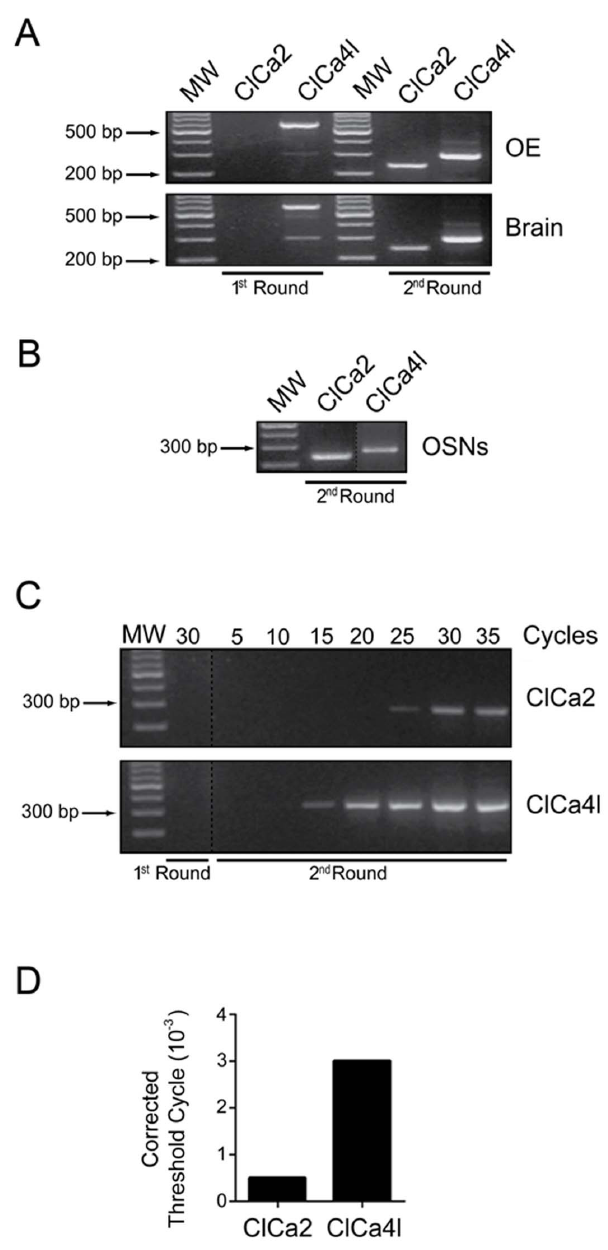
Figure 2. ClCa2 and ClCa4l are expressed in rat olfactory epithelium and olfactory sensory neuron. A. ClCa2 and ClCa4l mRNA expression in rat olfactory epithelium after the first (1 st ) and second (2 nd ) round of nested RT-PCR. We used a brain as positive control. B. Expression of both mRNAs in an isolated olfactory sensory neuron. RT-: Reverse transcriptase-free samples. MW: molecular weight marker (GeneRuler 100 bp plus DNA Ladder, Fermentas). C. Using the respective primers for each of the channels we conducted a first round of PCR (30 cycles) and a second round (35 cycles), from which we obtained samples in cycles 5, 10, 15, 20, 25, 30 and 35. D. RT q-PCR was used for determining the abundance of ClCa4l and ClCa2, using a single round with 35 cycles. The threshold cycle values were corrected with the rat housekeeping YWHAZ.